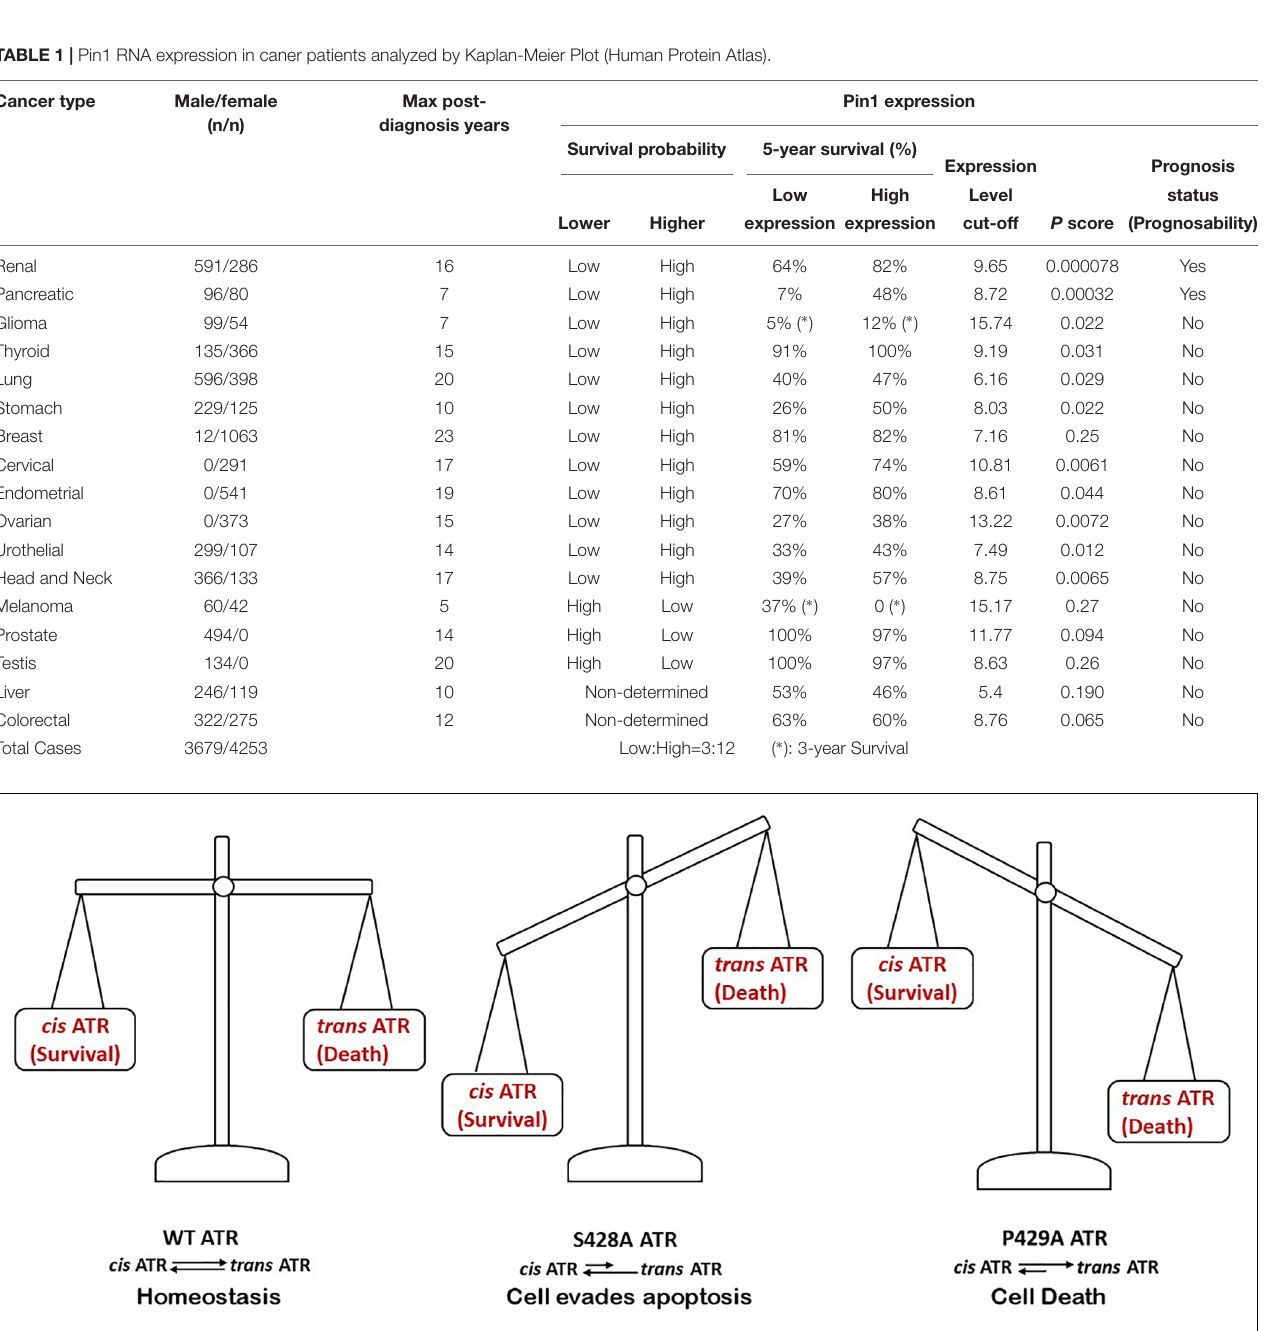
FIGURE 5 | An appropriate balance between cytoplasmic levels of cis- and trans- ATR is critical for the wellbeing of